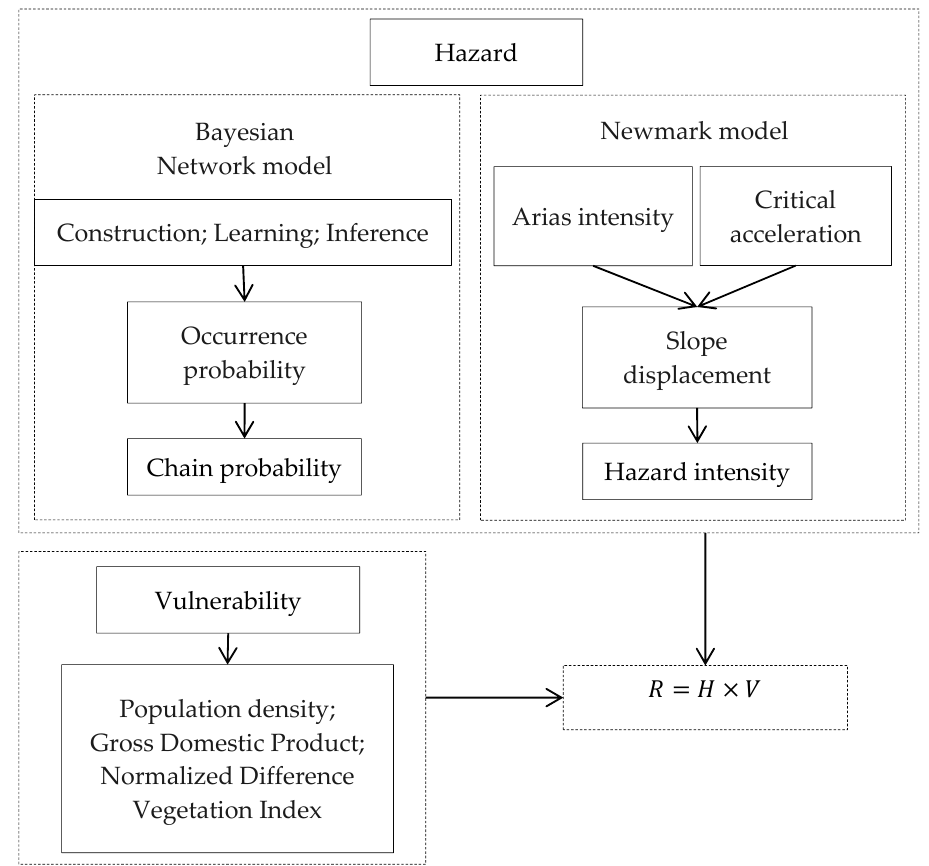
Figure 3. The risk identification steps of the earthquake disaster chain.